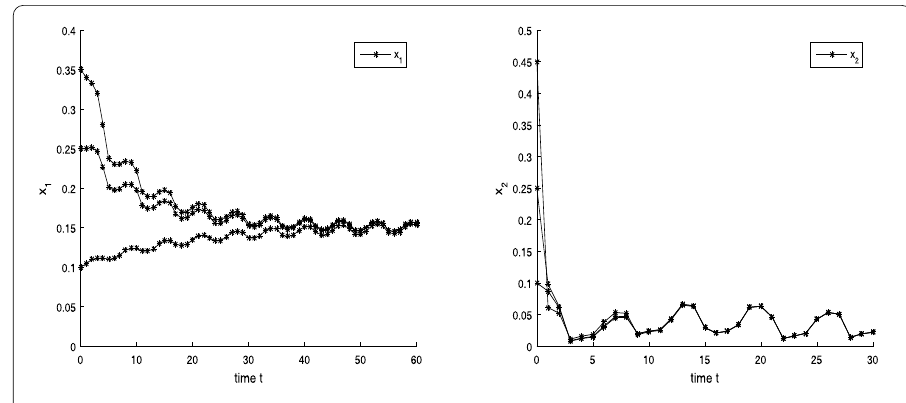
Figure 1 Dynamic behaviors of system (6.1) with initial condition ( x 1 ( t ), x 2 ( t )) T = (0.1,0.45) T ,(0.25,0.25) T ,(0.35,0.1)